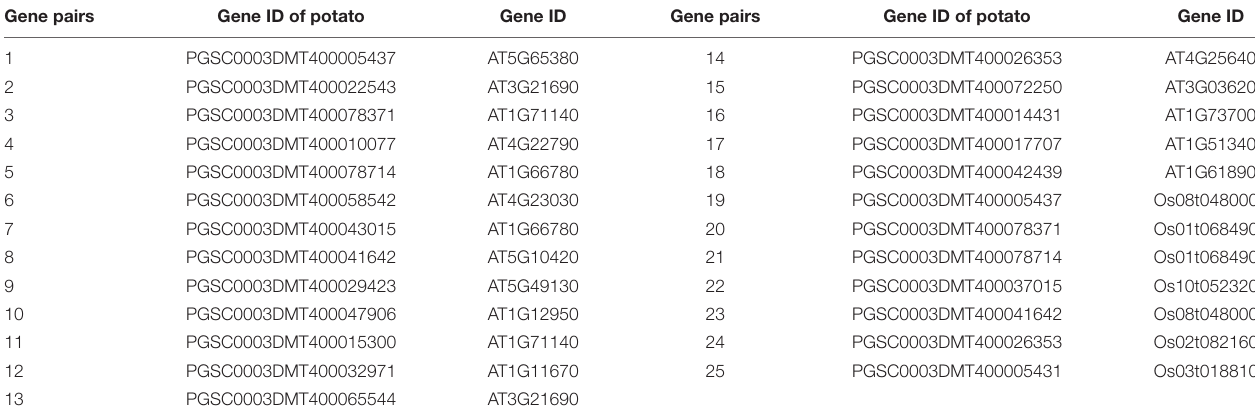
TABLE 1 | Twenty-five collinear gene pairs of multidrug and toxic compound extrusion (MATE) genes in Arabidopsis , potato, and rice. Gene pairs Gene ID of